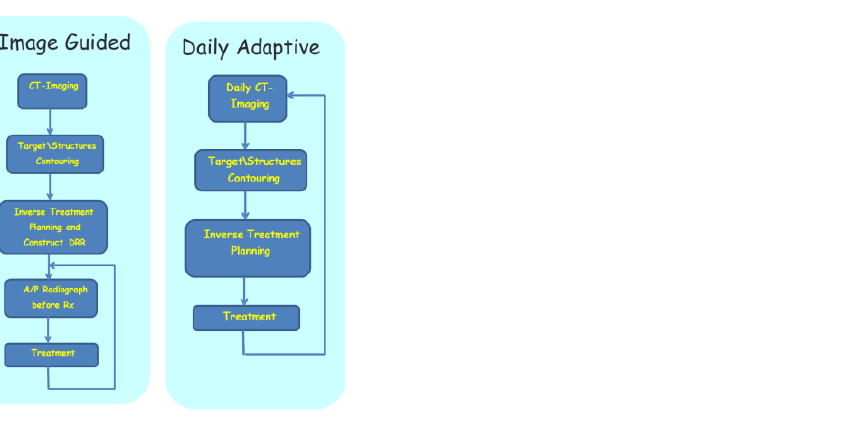
Figure 5. Adaptive image-guided HDREBT: top — workflow for image-guided brachytherapy (IGBT); bottom — workflow for daily adaptive